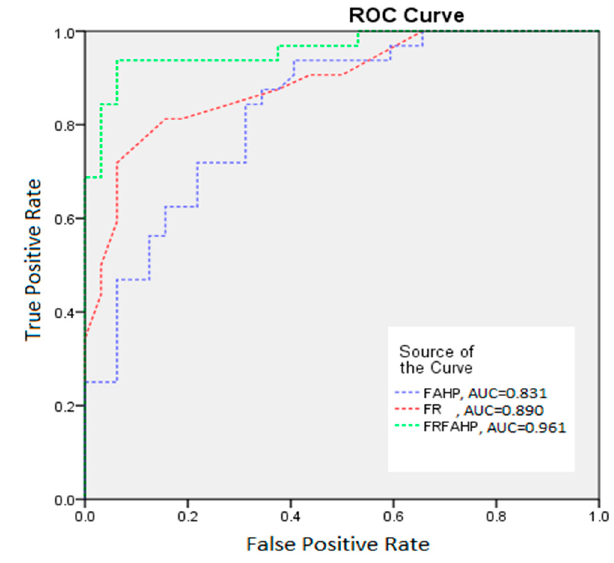
Figure 15. Landslide susceptibility map of the earthquake-a ff ected area based on three models.